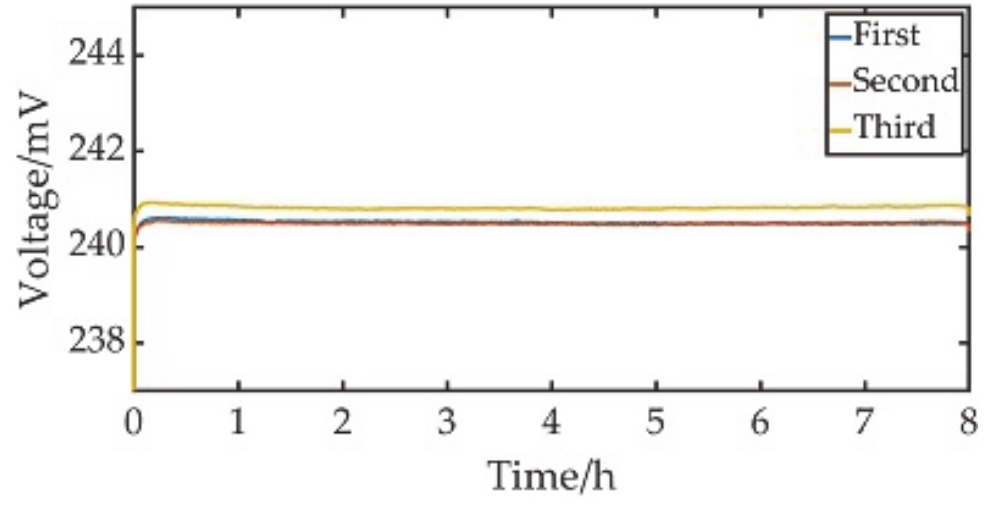
Figure 11. The output voltage of PD in Experiment 1.